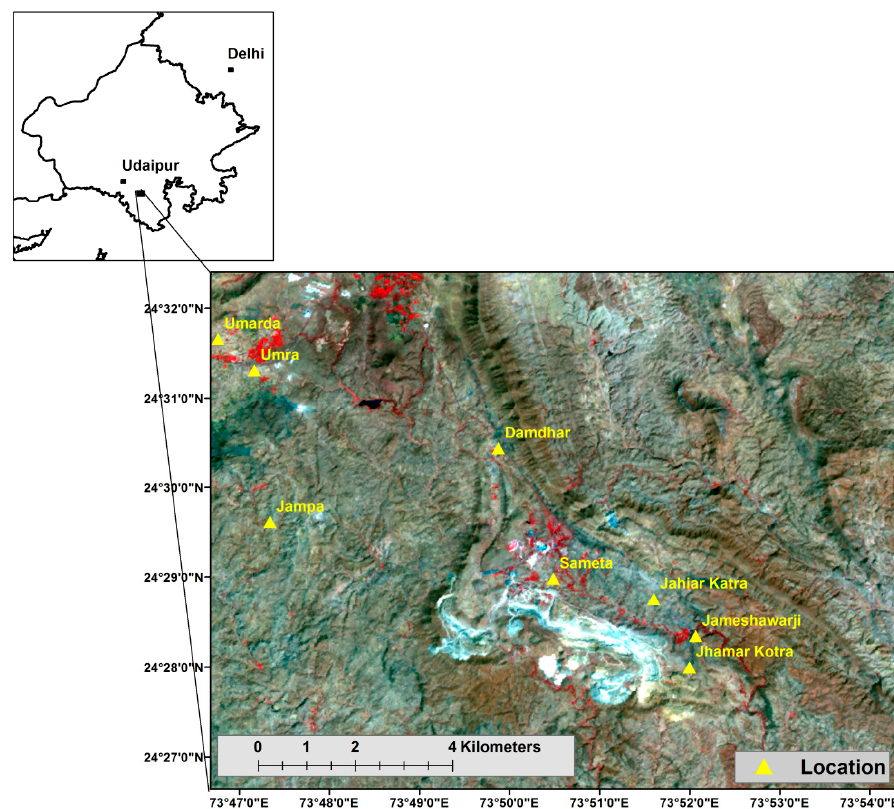
Figure 1. The extent of the study area is shown on the Advanced Spaceborne Thermal Emission and Reflection Radiometer (ASTER) false color composite image prepared using visible and near-infrared bands of ASTER. In this false color composite image, Red = Band 3 of ASTER visible near infrared (VNIR) sensor, Green = Band 2 of VNIR sensor, Blue = Band 1 of VNIR sensor of ASTER. For specification of ASTER VNIR bands, please refer table 1.